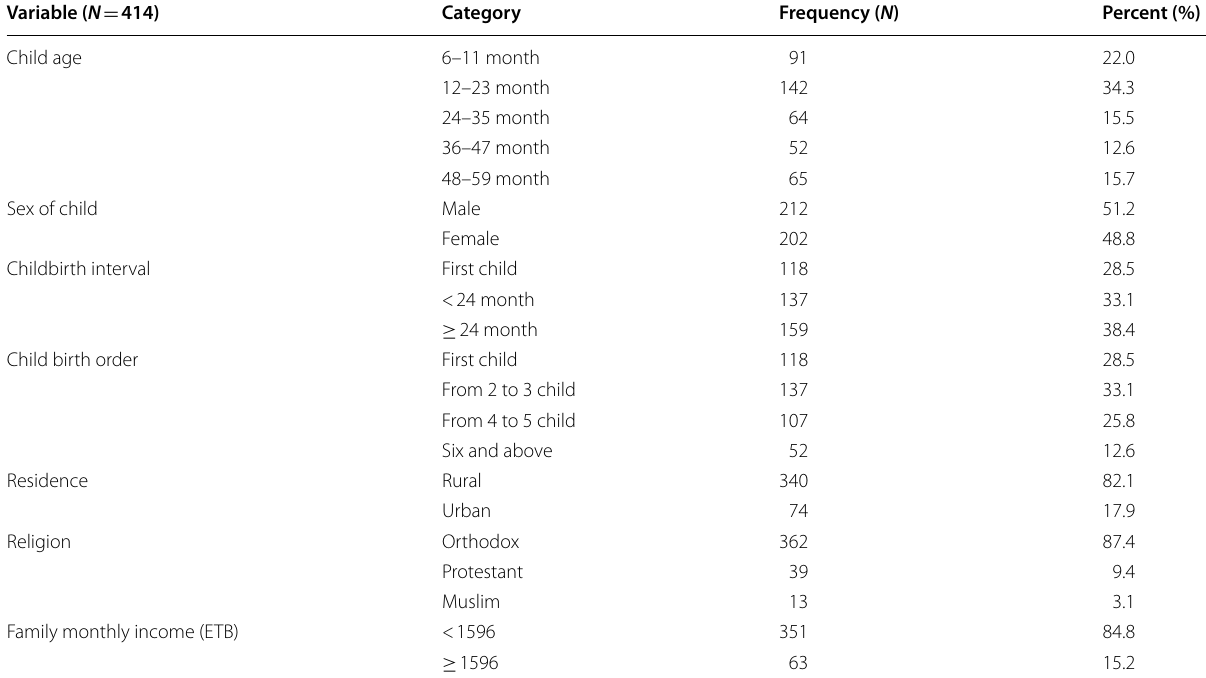
Table 1 Sociodemographic characteristics of children among 6–59 months in Angolela Tera district, North Shoa, Amhara,